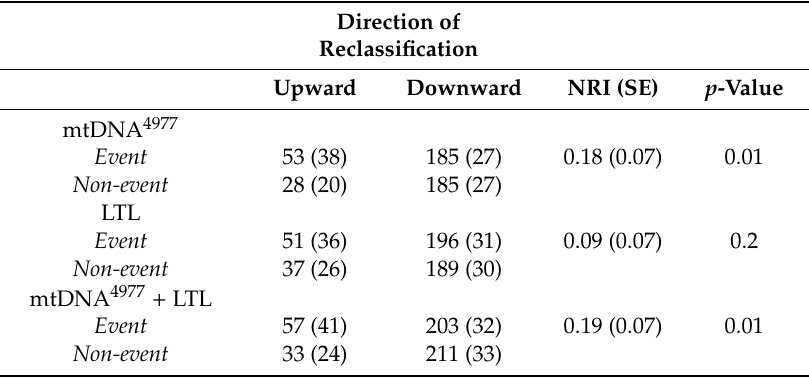
Table 4. Net reclassification improvement (NRI) for prediction of major adverse cardiovascular events by addition of the mtDNA 4977 and LTL to a baseline clinical